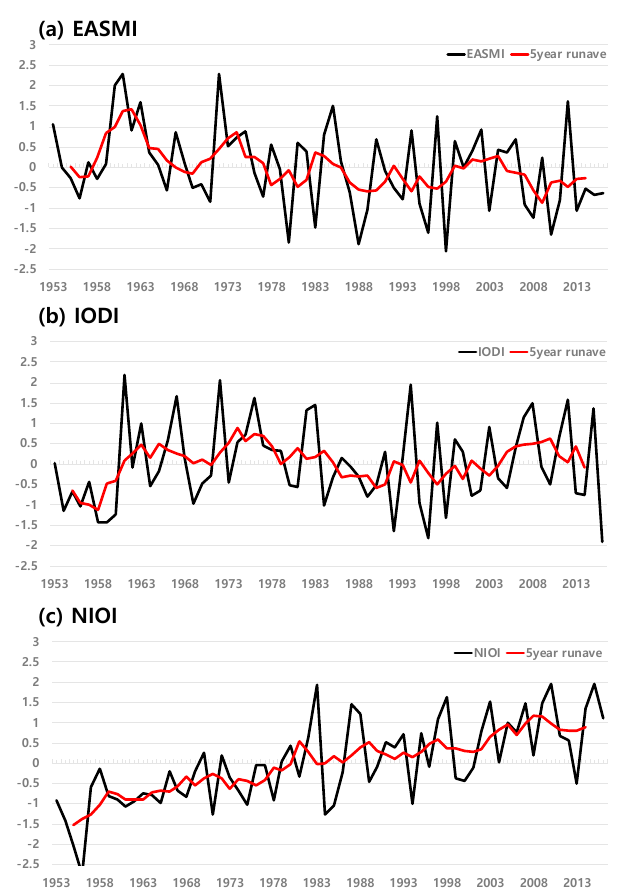
Figure 1. Time series of normalized ( a ) EASMI, ( b ) IODI and ( c ) NIOI for 1953–2016. Black line represents each index and red line displays their 5-year (from year − 2 to year +2 period) running average.